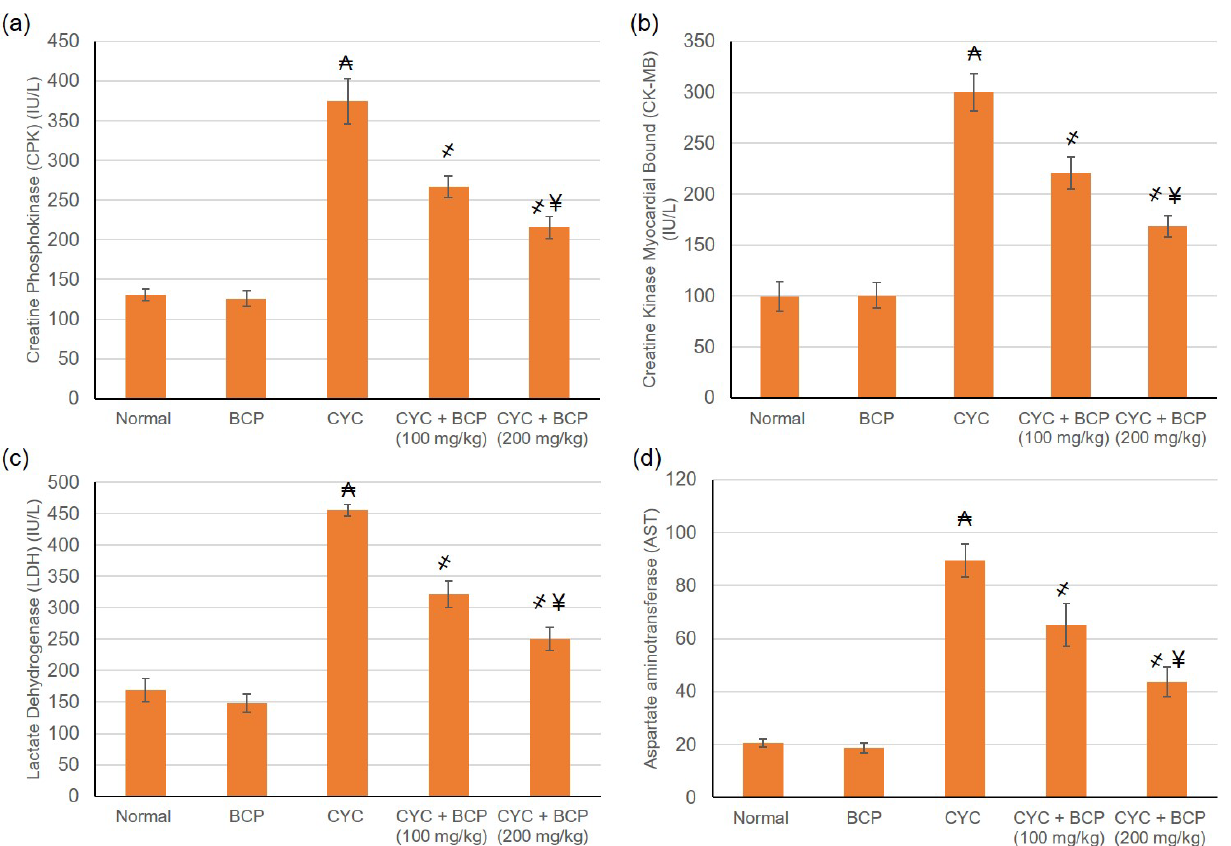
Figure 2. Effects of treatment with β -caryophyllene (BCP) for 14 days on cyclophosphamide (CYC) induced escalation in cardiac indices including ( a ) CPK, ( b ) CK-MB, ( c ) LDH and ( d ) AST in rats. All values are expressed as mean ± SD. ₳ indicates a statistically significant difference from normal group; indicates a statistically significant difference from CYC group; ¥ indicates a statistically significant difference from CYC + BCP (100 mg/kg) utilizing one-way ANOVA then Tukey’s post ҂ hoc analysis ( p < 0.05).